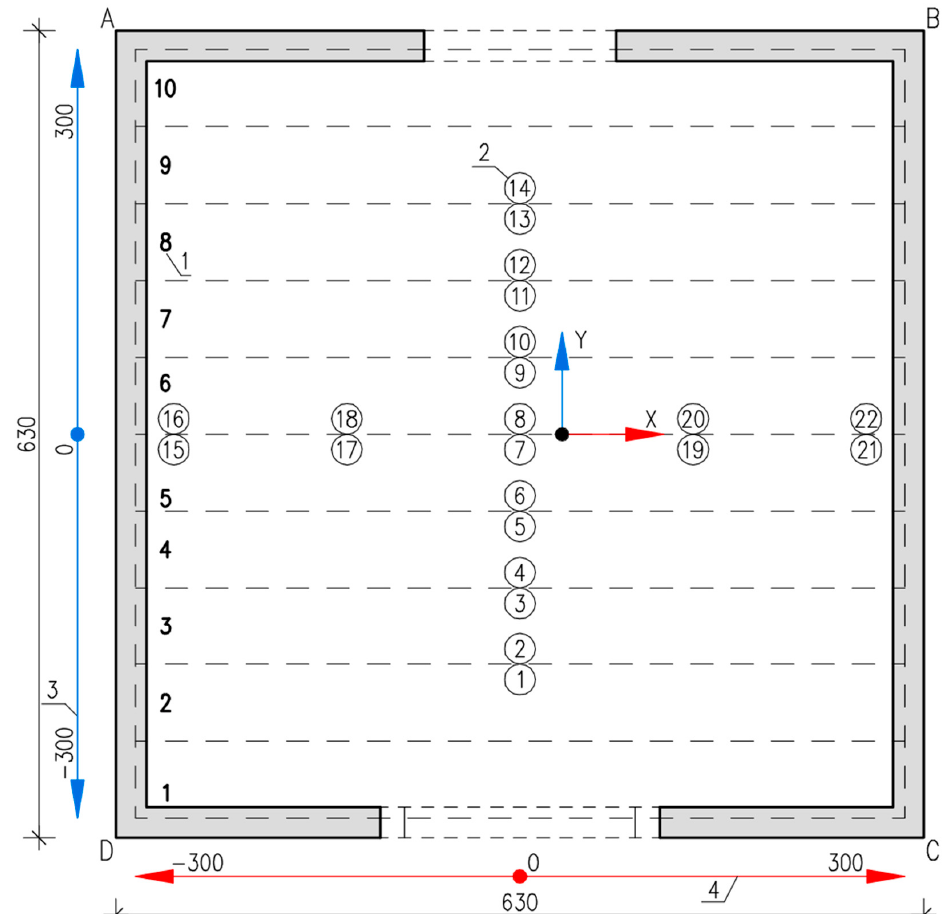
Figure 9. Arrangement of the transducer and geodetic sensors for measuring vertical displacements on the lower surfaces of the tested slabs: 1—panel number, 2—sensor number, 3—measurement direction transverse to the main direction of the panels (Y-axis), and 4—measurement direction along the length of the central panels joint (X-axis).